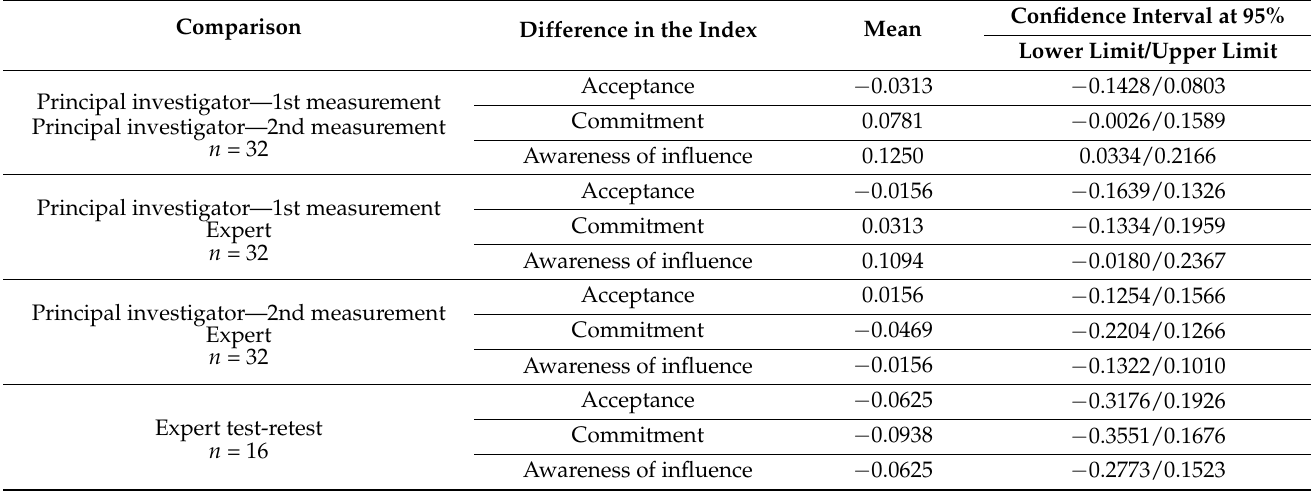
Table 4. Mean values of the differences between each pair of evaluations and their confidence interval at